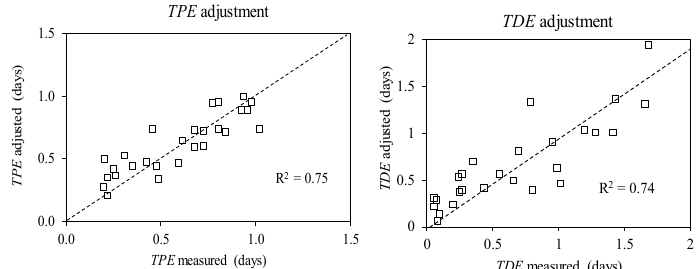
Figure 8. Goodness of adjustment of the time to peak of the suspended sediment concentration ( SSC )